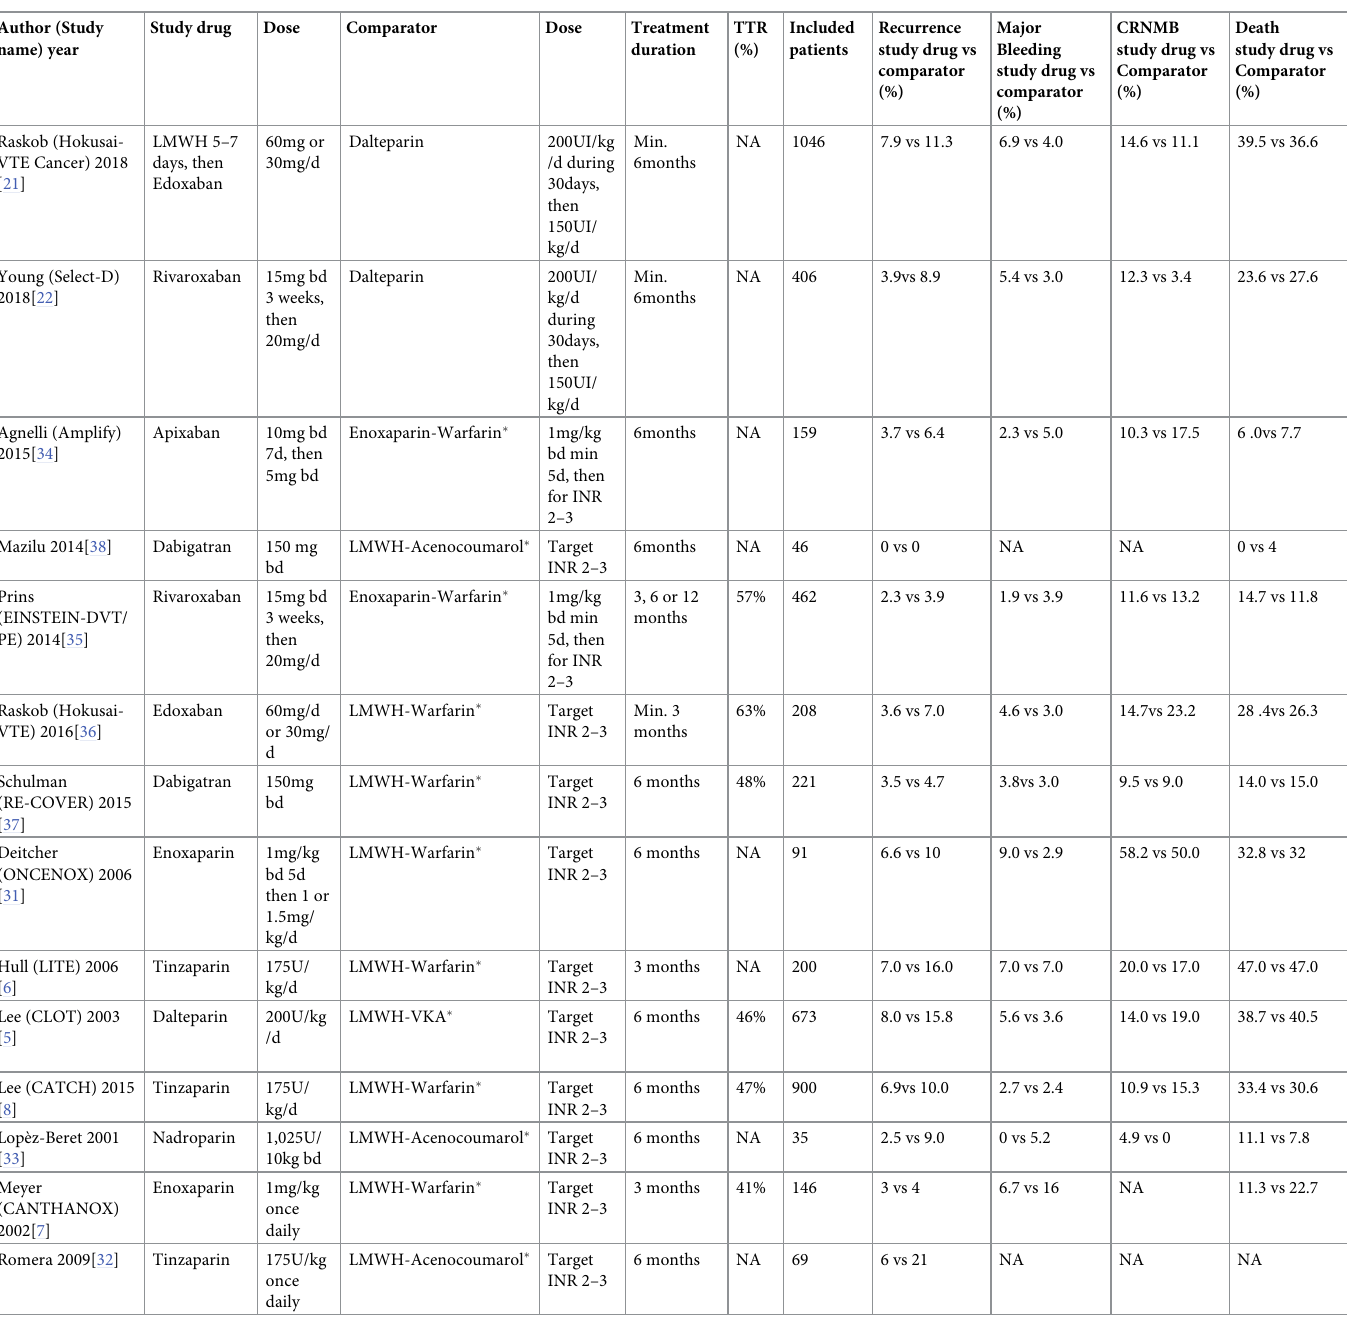
Table 1. Characteristics of included studies.